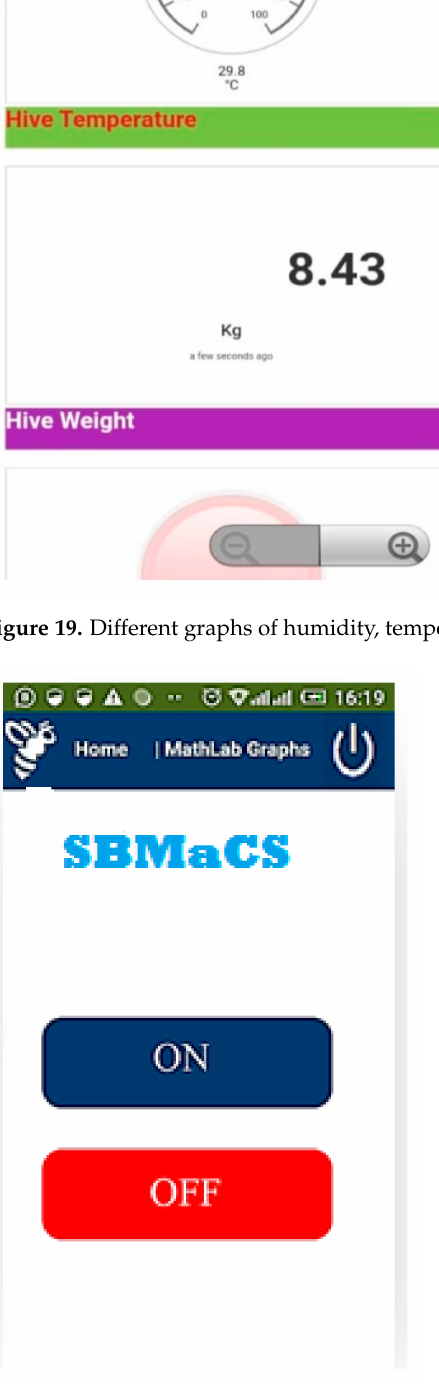
Figure 20. Graph of shutting down the